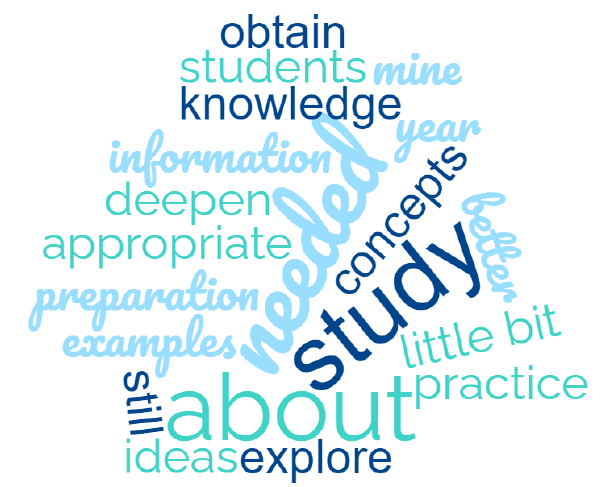
Figure 3 . Word cloud of answers to the question “If you